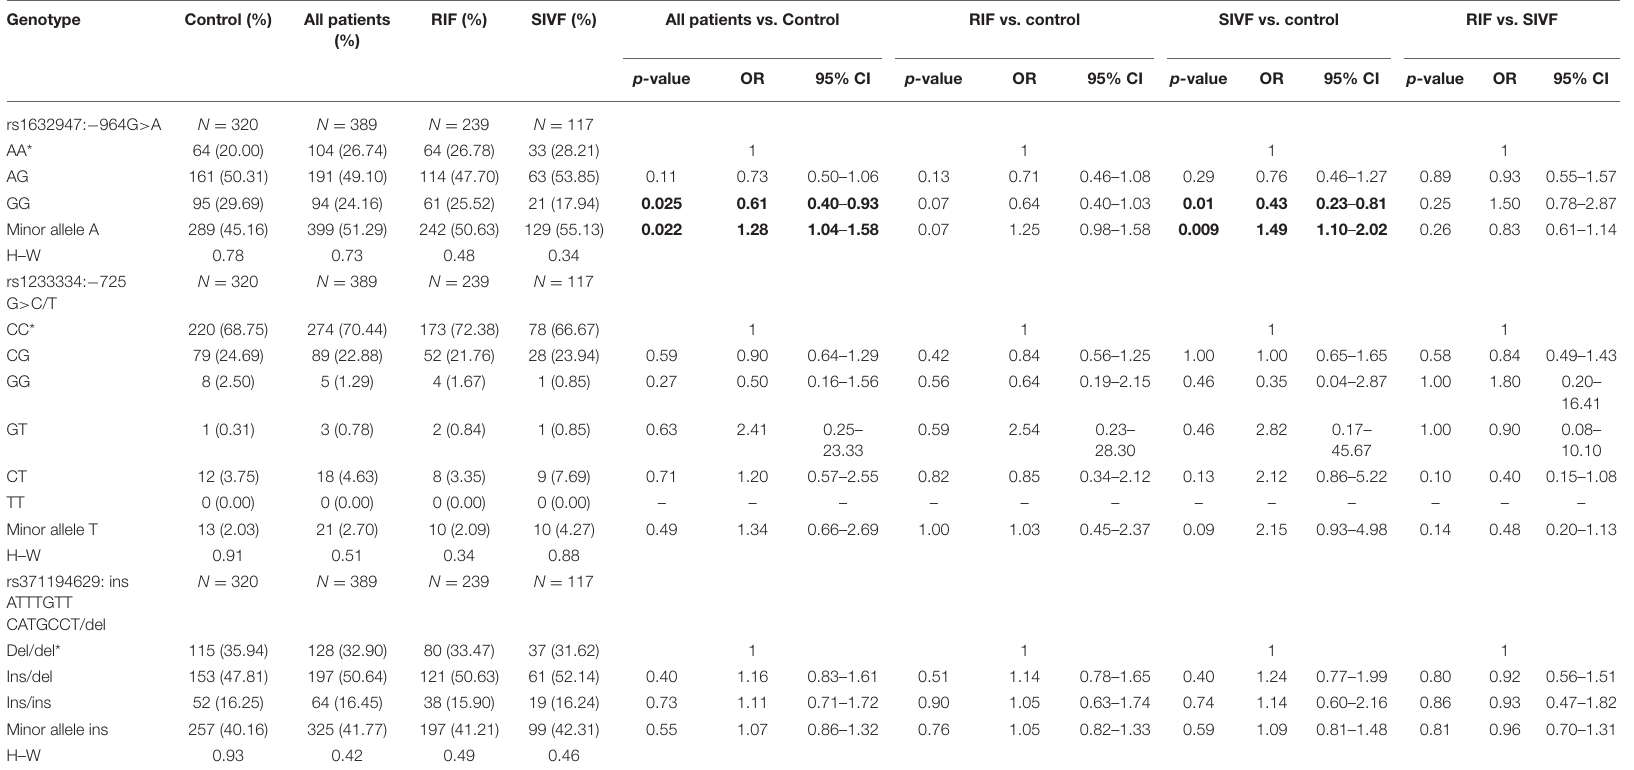
TABLE 2 | HLA-G genotype and minor allele frequencies in women from control and patient groups.